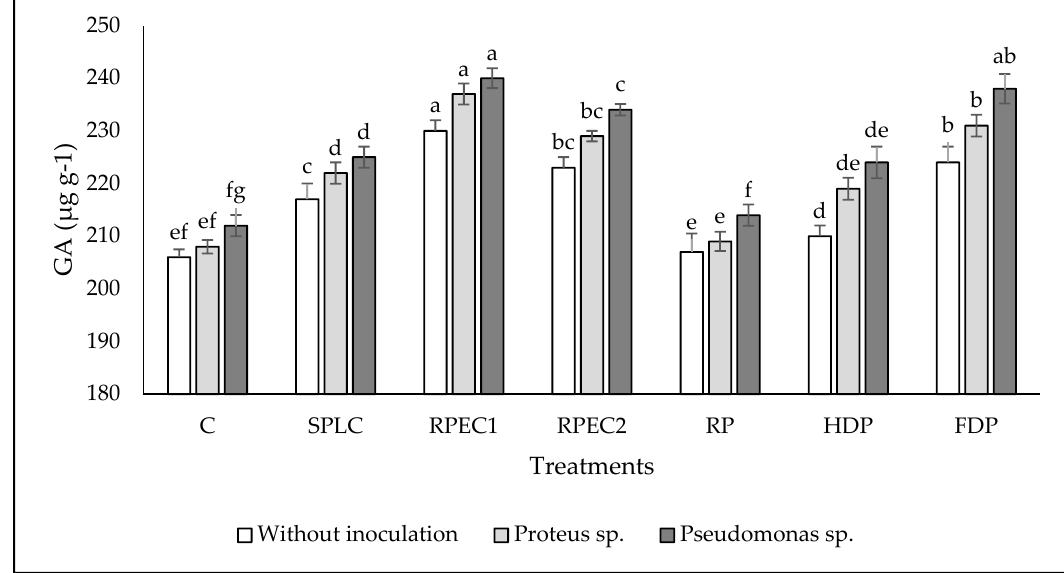
Figure 3. Effects of PGPR, P-enriched compost and inorganic fertilizers on leaf GA concentration (µg g -1 ) in wheat. C-Control; SPLC-Poultry litter only; RPEC1-Rock phosphate + poultry litter solubilized with Pseudomonas sp. during the composting process; RPEC 2 -Rock phosphate + poultry litter solubilized with Proteus sp. during composting process), RP-Rock phosphate + poultry litter; HDP- Half dose inorganic P from Single Super Phosphate-SSP 18% P 2 O 5 ; FDP- Chemical fertilizer (Single Super Phosphate). All the treatments sharing common letter are similar otherwise they differ significantly at p ≤ 0.05.